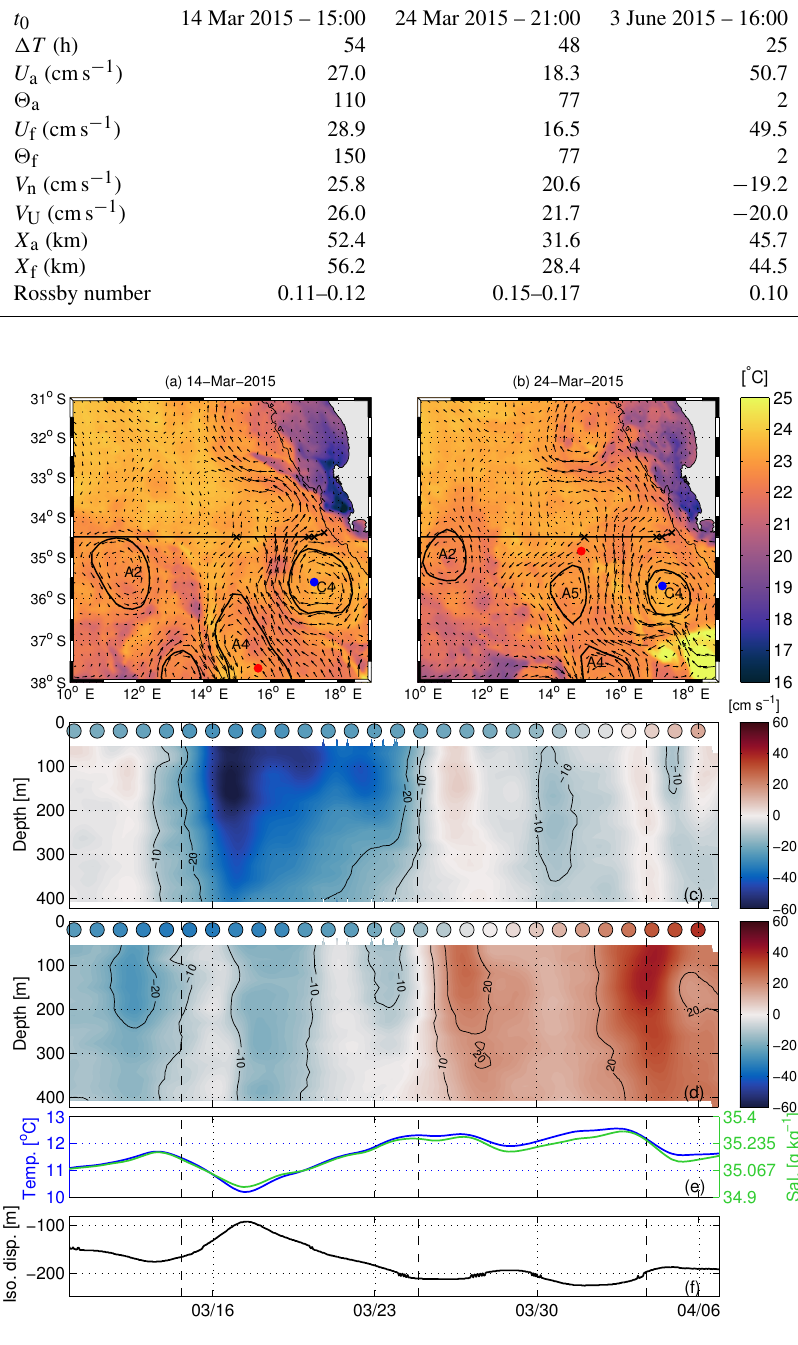
Figure 8. Anticyclonic eddy: (a, b) SST satellite images for selected dates (vertical black lines on the time series). Vertical–temporal section of the u component (c) and v component (d) of the current speed measured from the upward-looking ADCP at M4. The colored circles at the top of the section show the u and v component of the current speed from altimetry data. (e) Temporal evolution of temperature (blue line) and salinity (green line) and (f) the isopycnal displacement recorded at the first SBE37 MicroCATs between 430 and 450m